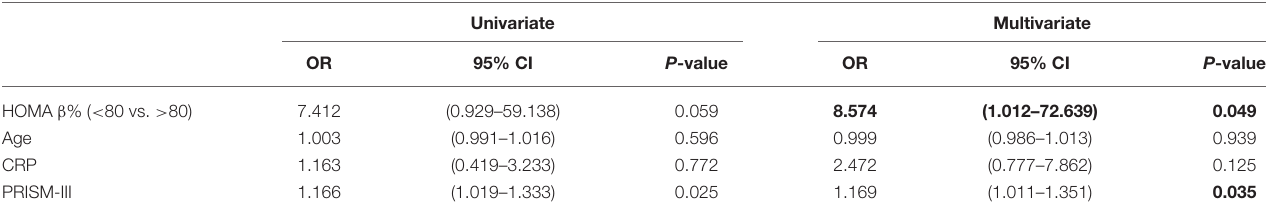
TABLE 3 | Predictors of mortality in the studied patients ( N =